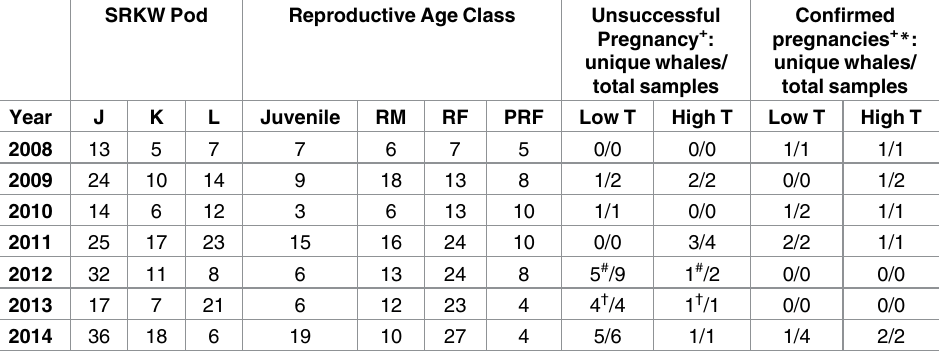
Table 2. Pod composition and samples per unique successful and unsuccessful pregnancy from genotyped females per year. SRKW Pod Reproductive Age Class Unsuccessful